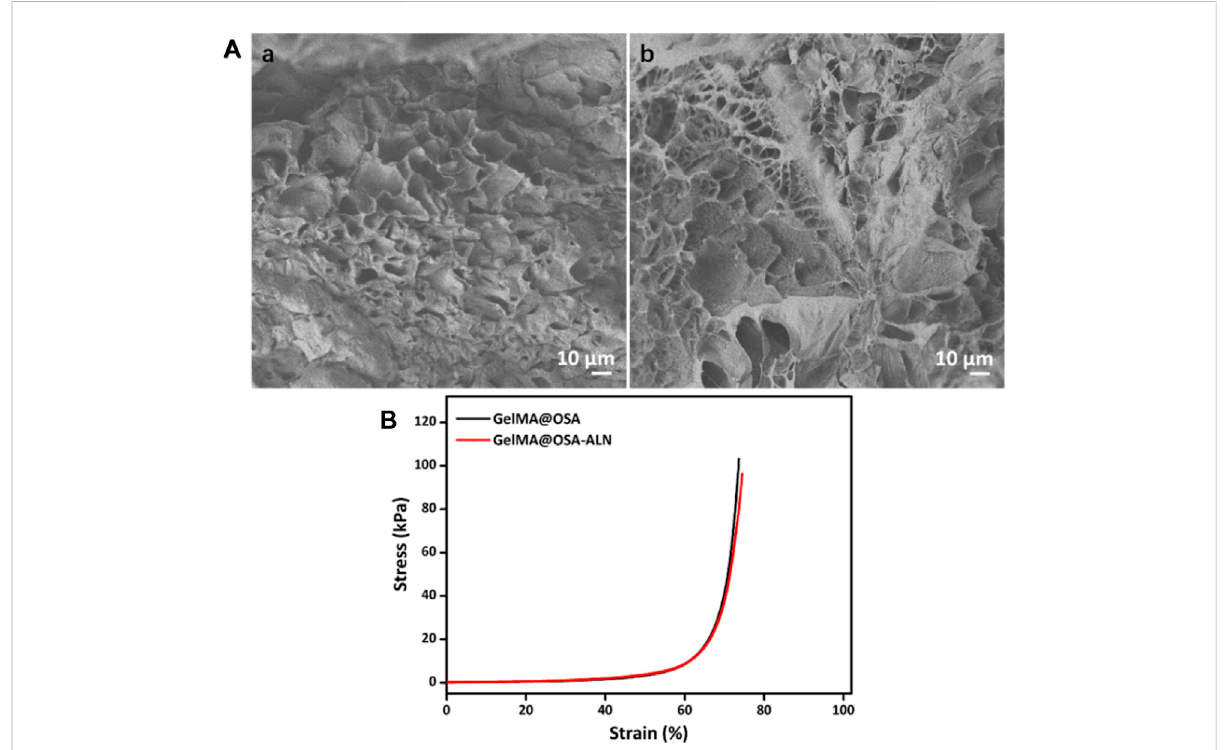
FIGURE 3 Morphologicalandmechanicalcharacterizations. (A) SEMimagesand (B) Compressivecurvesof (a) GelMA@OSA and (b) GelMA@OSA-ALNDN hydrogels.